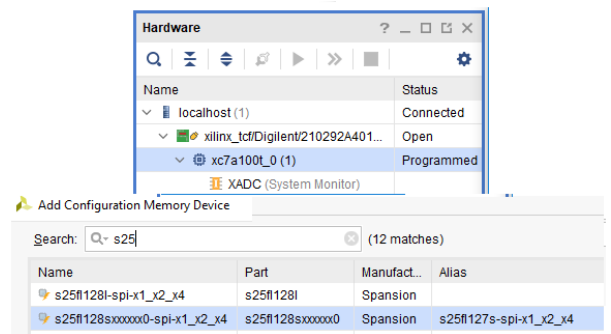
Figure 19. Flash memory device for Nexys 4 DDR.